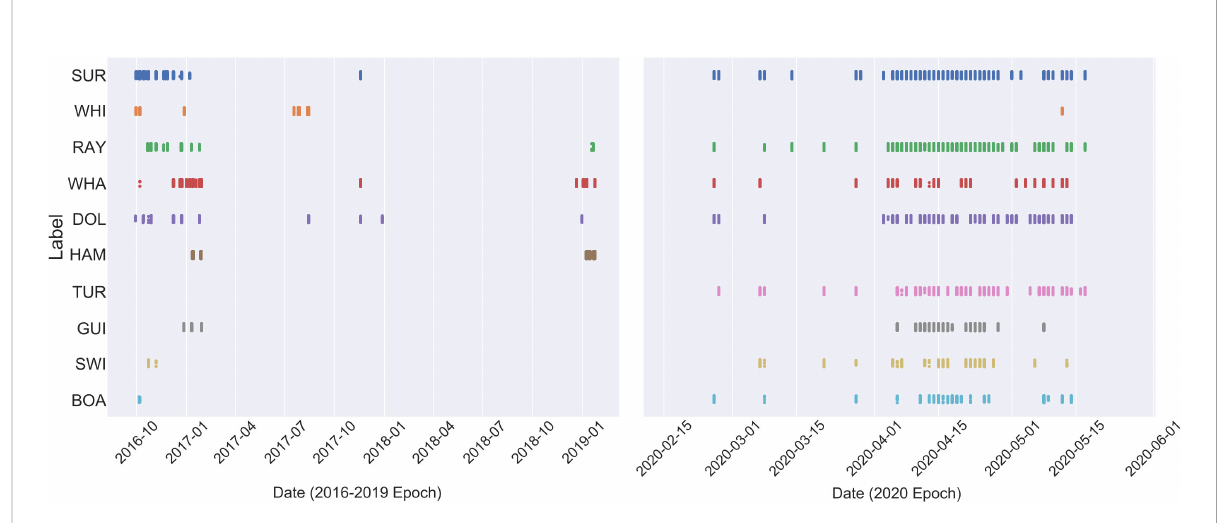
FIGURE 2 Illustration of the spread in dates during which objects of interested were detected. Detections during 2020 are less sparse than during 2016/ 2017/2019 as the 2020 trials were designed with training and validation of the machine learning algorithms in mind. Each object class is represented as a three letter code as follows: SUR, surfer; RAY, ray; WHI, white shark; WHA, whaler shark; DOL, dolphin; HAM, hammerhead shark; TUR, turtle; GUI, guitar fi sh; SWI, swimmer and BOA,